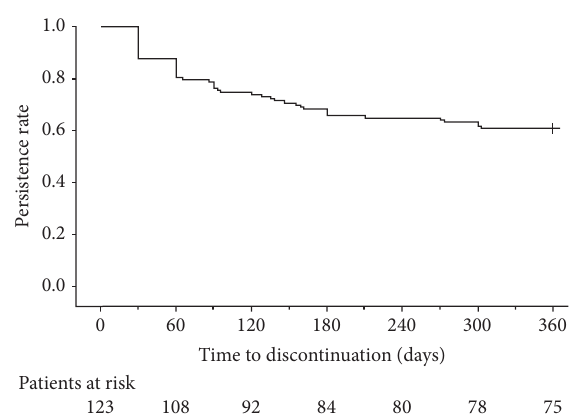
Figure 2: Survival curve for overall persistence with once-daily teriparatide during the 12-month study period. Persistence was definedasthetimefromthestartoftreatmenttothediscontinuation of treatment. Discontinuation was defined as a 60-day gap in once- daily teriparatide supply. + indicates censored.